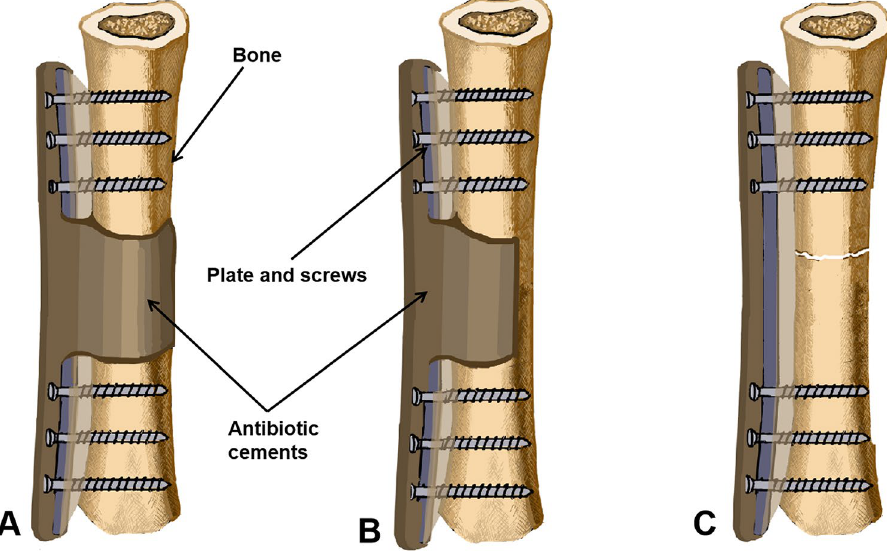
Figure 1. Schematic diagram of antibiotic cement plate composite structure, it is divided into three types according to the shape of bone defects. ( A ) Segmental bone defects; ( B ) partial bone defects, ( C ) no bone defect but with unhealed